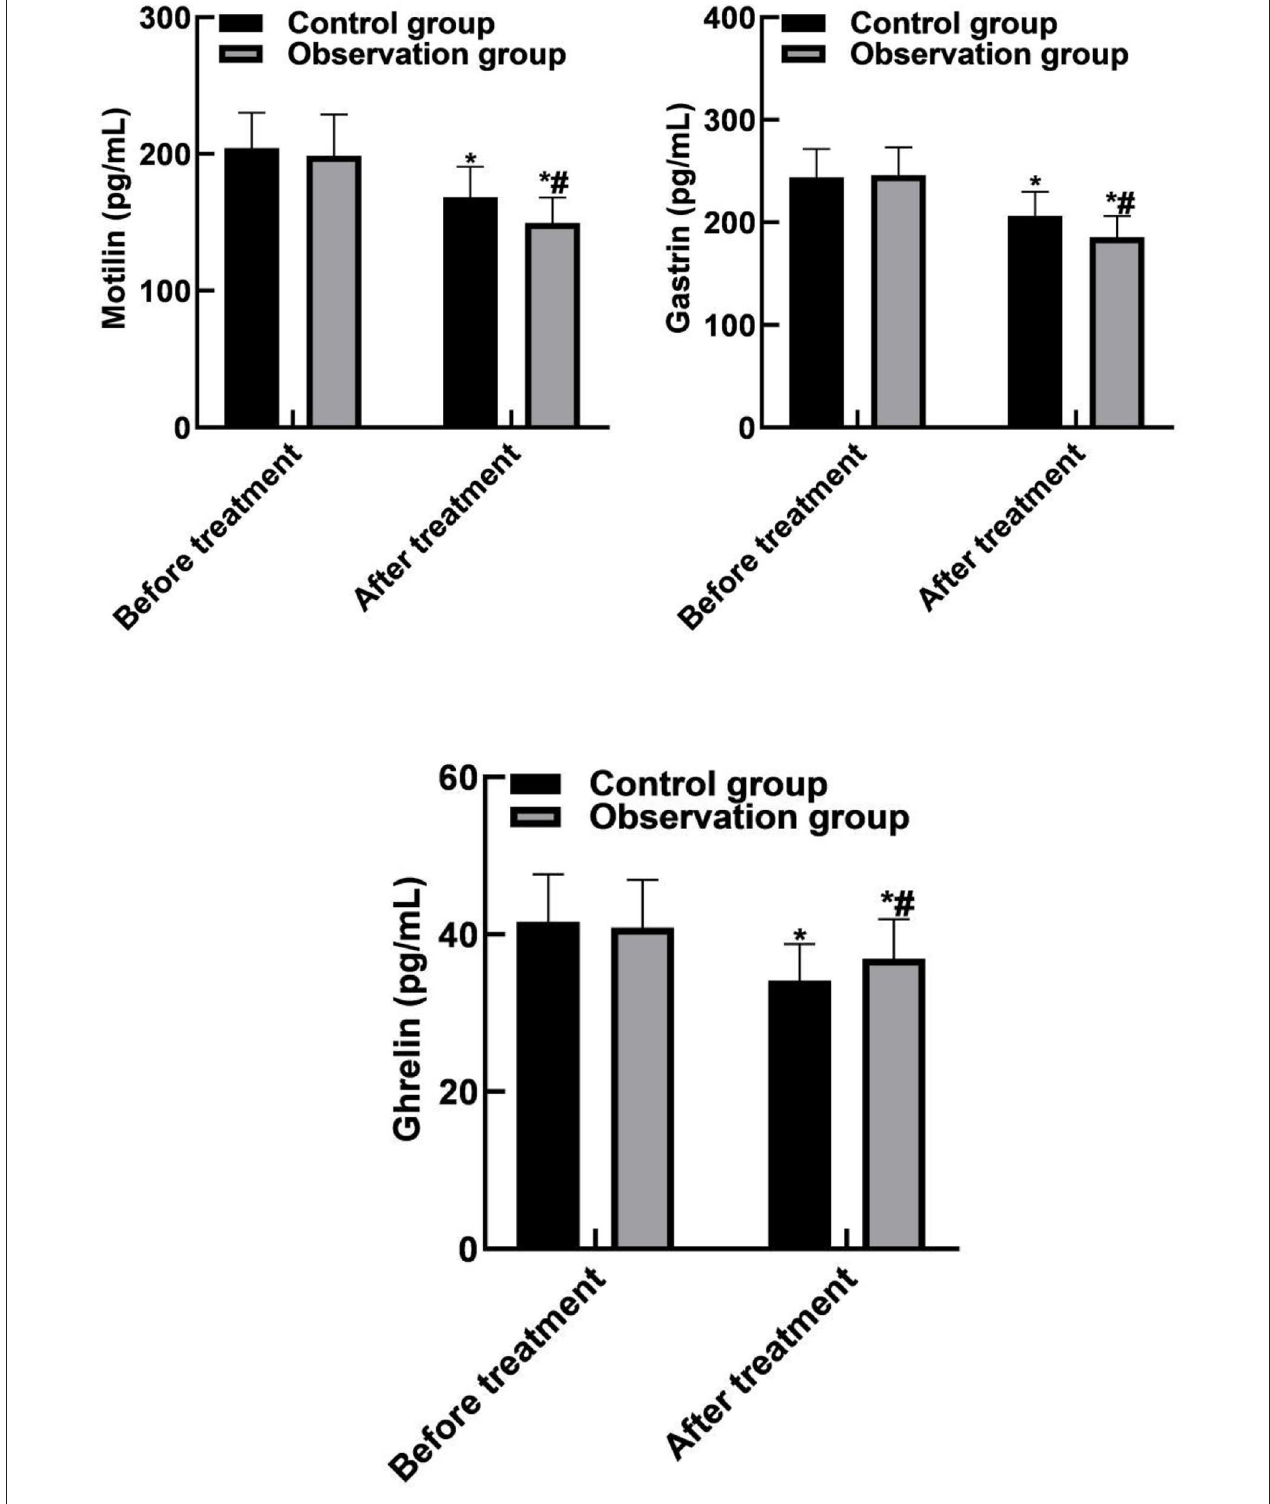
FIGURE 2 | Comparison of brain-gut peptide indicators between the two groups. Compared with before treatment, * P < 0.05. Compared with the control group, # P < 0.05.